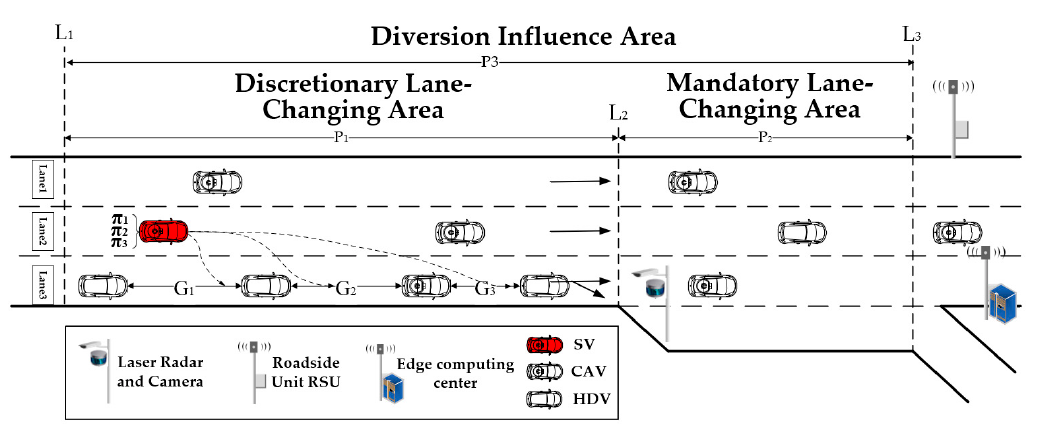
Figure 1. The schematic of the diverging influence area.